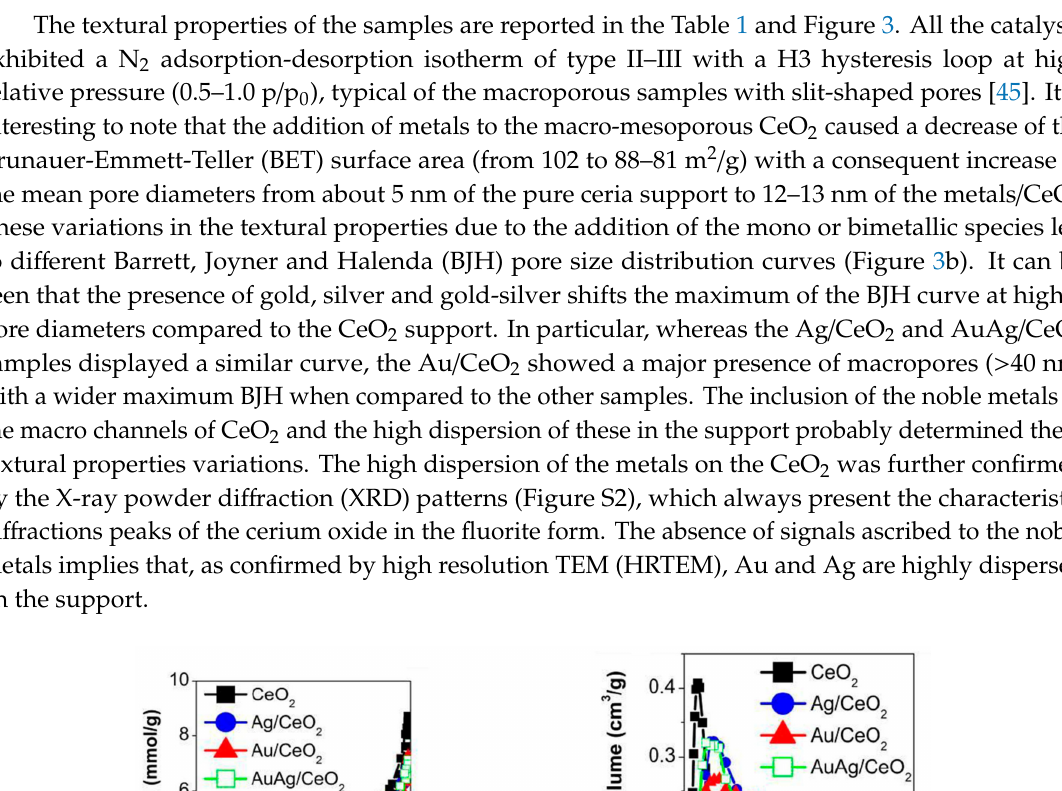
Figure 2. ( a ) Transmission Electron Microscopy imagine of the macro-mesoporous CeO 2 support. ( b ) Close inspection of the Au / CeO 2 sample.